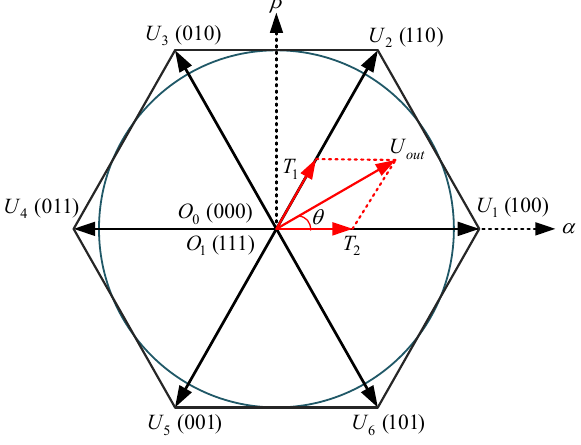
Figure 3. Voltage space vectors based on the SVPWM implemented on TMS320C24x/F24x.